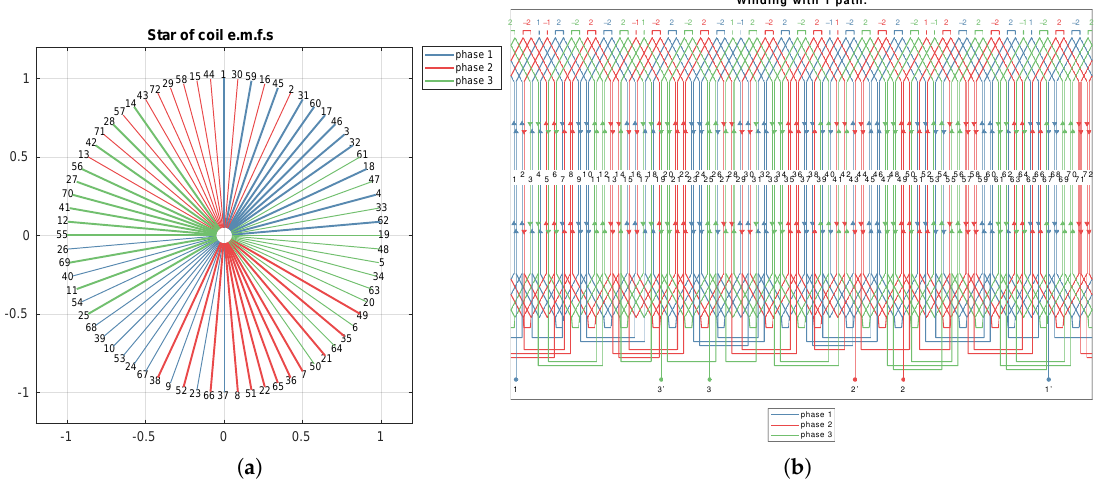
Figure 16. Double chording with a 3rd-order double-sided imbrication for N = 72, p = 5, m = 3 and q = 2 + 2 / 5 . ( a ) Star of slots and ( b ) winding scheme.